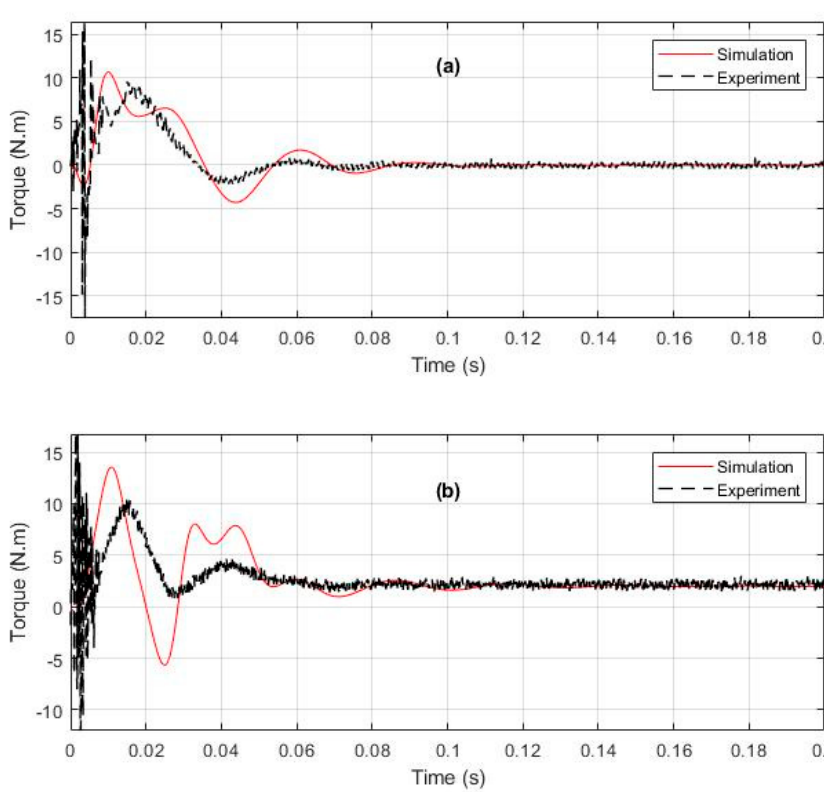
Figure 22. Torque response ( a ) no-load ( b ) full-load.